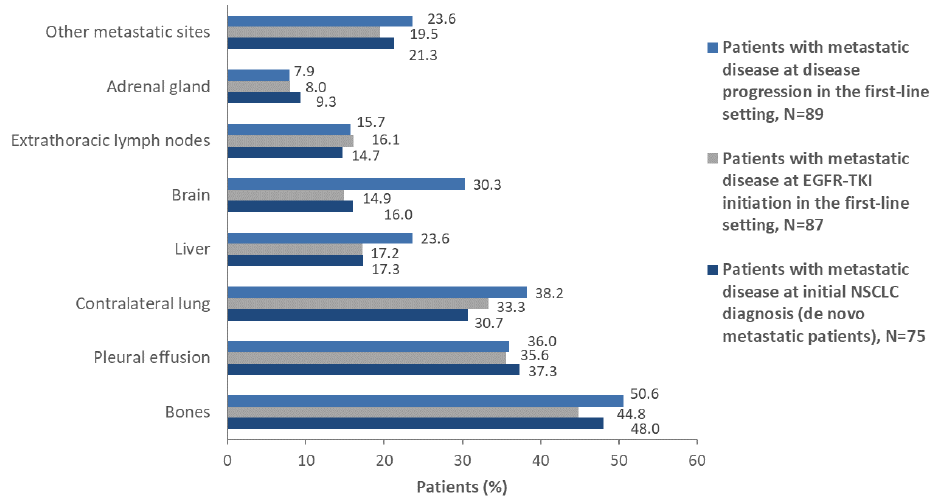
Figure 3. Sites of metastasis at initial diagnosis, EGFR-TKI initiation in the first-line setting, and at disease progression in the first-line setting, in patients of the overall population with metastatic disease.